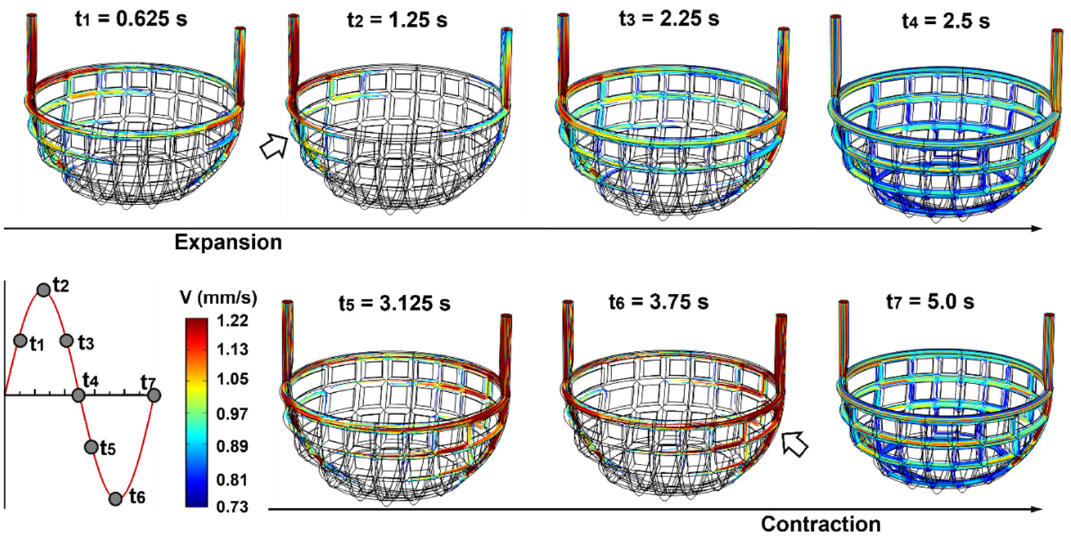
Figure 3. Streamlines of the blood flow within the capillary vessels at varying instants during alveolar expansion ( upper panel ) and contraction ( lower panel ).